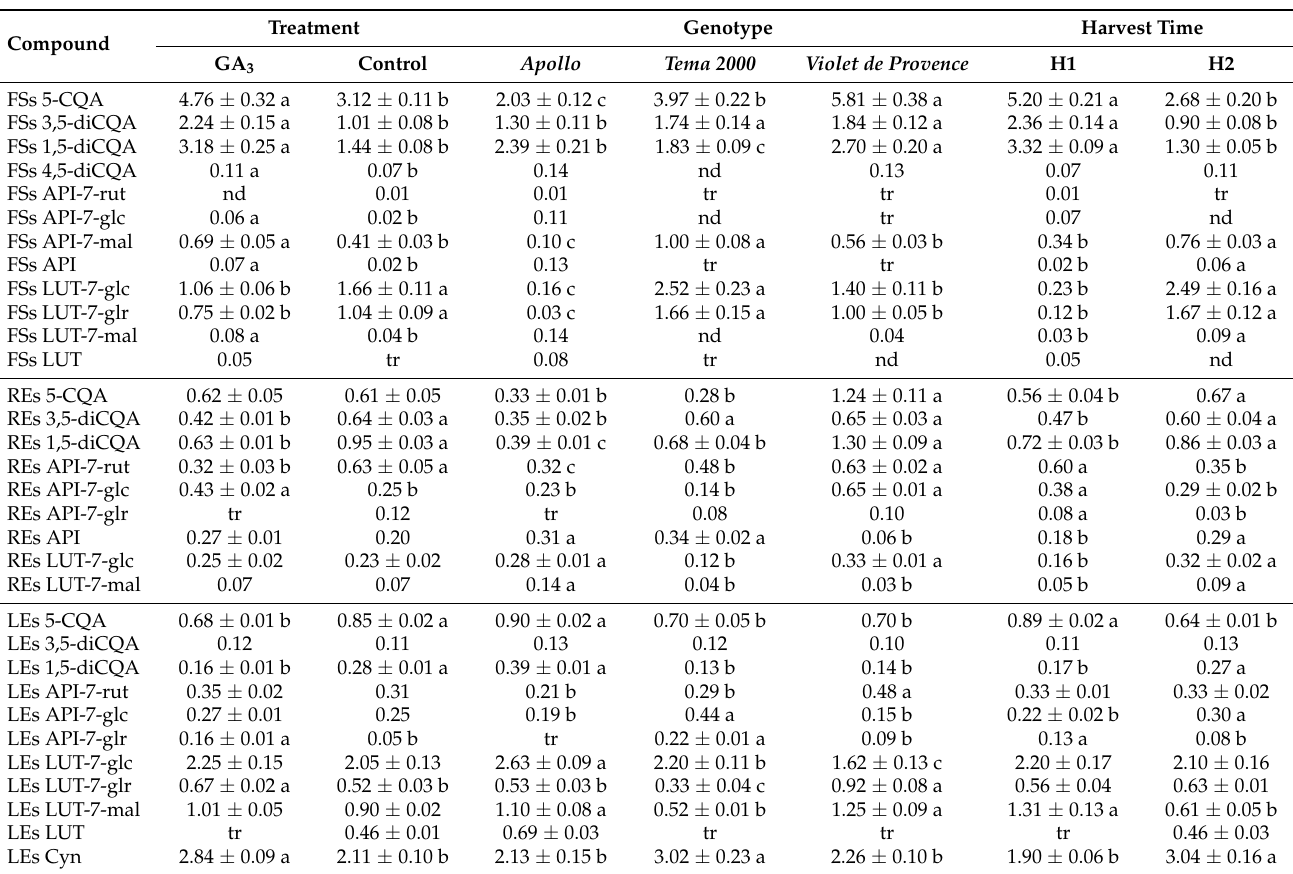
Table 5. Polyphenol profiles (g kg − 1 of D.M.) of the floral stems (FSs), receptacles (REs) and leaves (LEs) of globe artichokes as affected by the main effects under study. Different letters within the same row and factor under study show significant differences among means ± s.d. (LSD test, p < 0.05) (when s.d. < 0.001, it is no